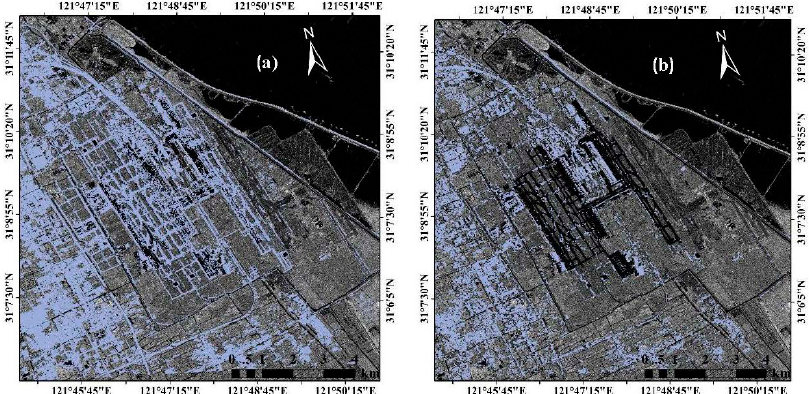
Figure 3. Comparison between the number of selected PS points using the present strategy ( a ) and traditional ADI method ( b ).